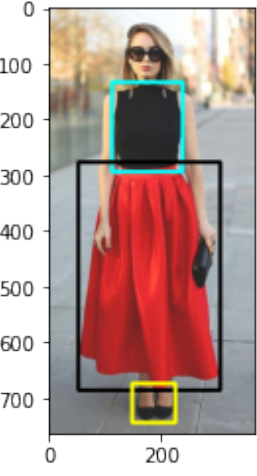
Figure 8. Original image.